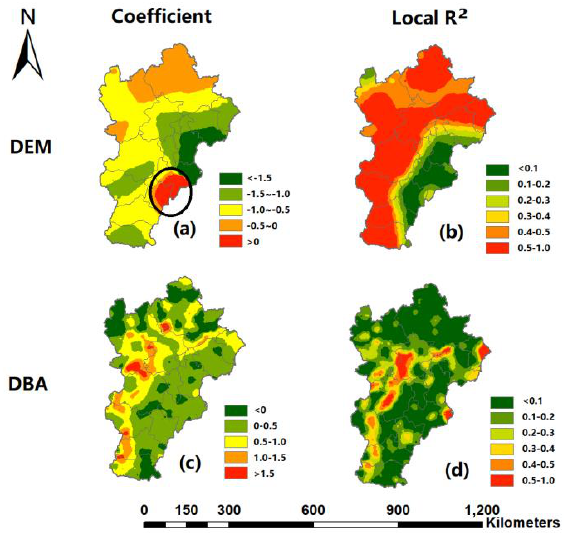
Figure 3. Spatial distribution of coefficients and local R 2 of DEM ( a , b ) and DBA ( c , d ) by GWR in the BTH.